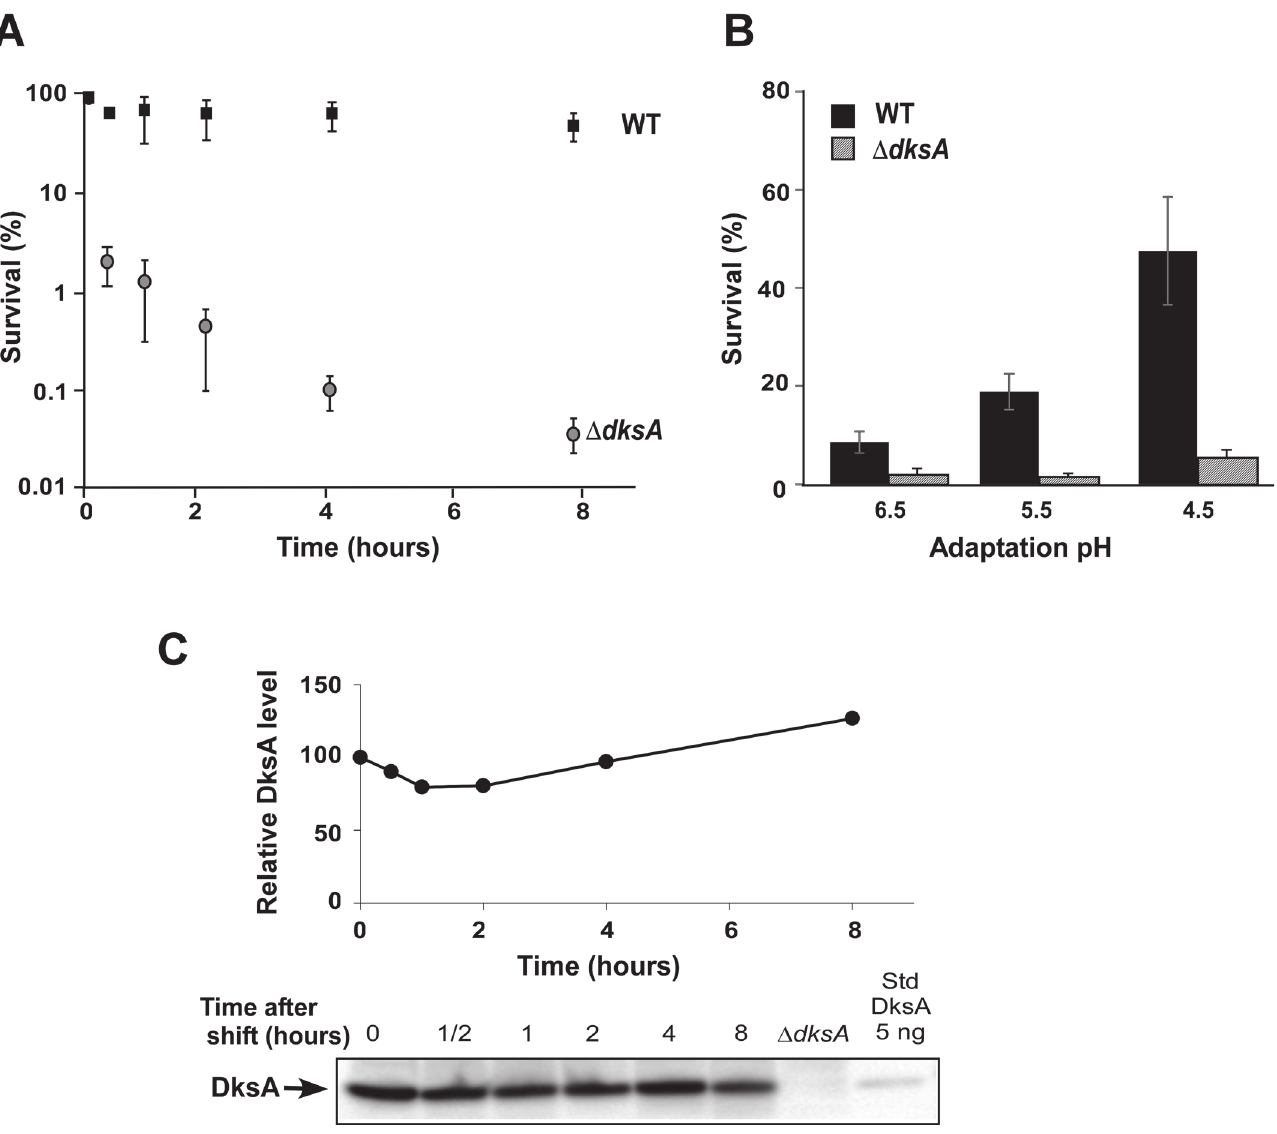
Fig 1. Δ dksA mutants are sensitive to acidic conditions. (A) WT and Δ dksA E . coli strains were grown overnight in rich medium at pH 7.8. Cultures were diluted 1:50 into LB medium at pH 2.5. At selected time points aliquots were taken and the percentage of survival of bacteria was determined using viable count. (B) WT and Δ dksA E . coli strains were grown at pH 7.8, followed by 2.5 hour adaptation at pH 6.5 – 4.5, and then diluted into LB medium at pH 3.5. Survival was determined using viable counts; the result after 2 hour incubation at pH 3.5 is shown. (C) DksA concentration remains relatively constant at low pH. Samples taken at different time points after a change in pH were analyzed using Western blotting with anti-DksA antibodies. Extract from the Δ dksA strain and purified DksA were loaded as controls.